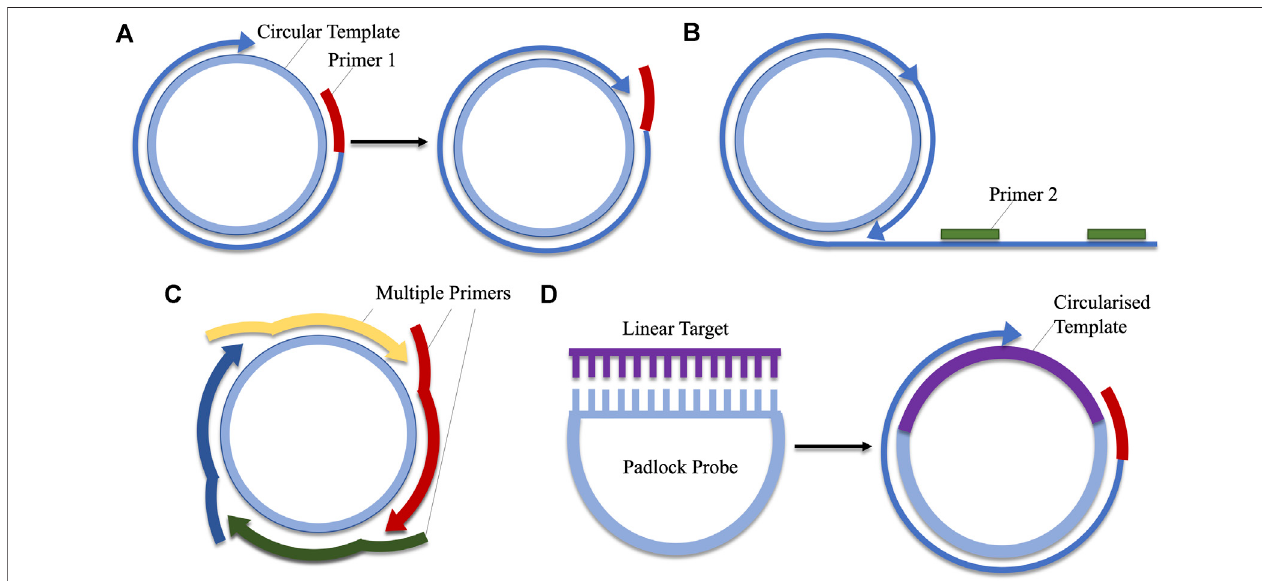
FIGURE 4| A comparison of the various types of rolling circle ampli fi cation. (A) Linear ampli fi cation using a single primer. (B) Hyper-branched RCA adds asecond primer which aids in exponential ampli fi cation by binding to regions on the repeated DNA sequence. (C) Multiply-primed RCA also facilitates the production of large amounts ofampliconviathe useofseveralprimerswhich bindtodifferentregions onthecircularDNA. (D) Padlocks probescontainsequences complementarytolinear DNA. Hybridisation of these regions facilitates ligation, producing a circularised template which can be employed in RCA.